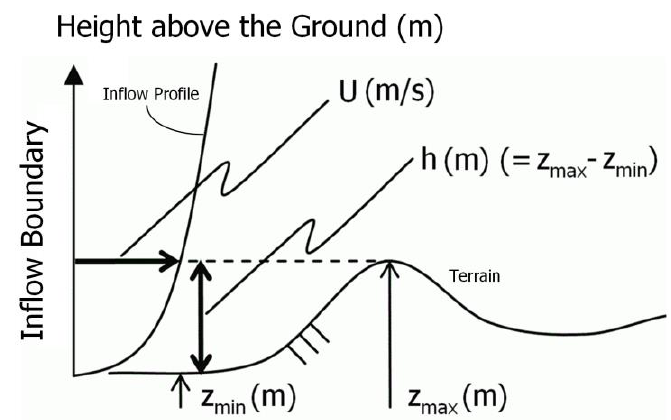
Figure 10. Characteristic scales U and h .